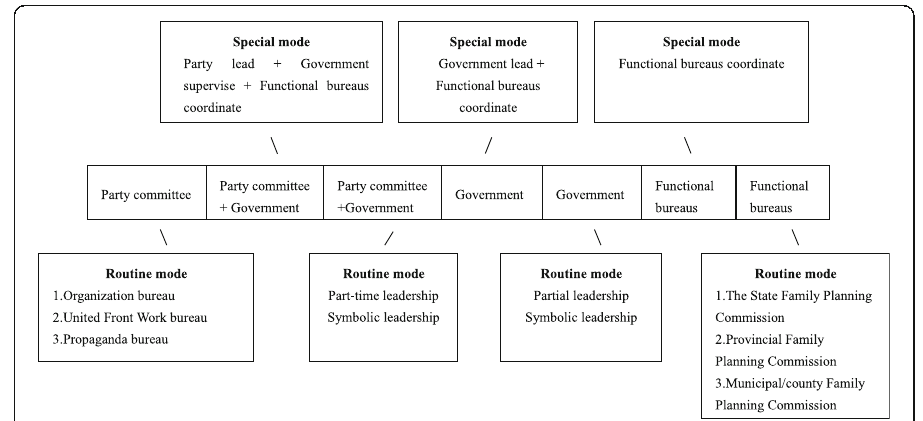
Fig. 4 Different modes of family planning